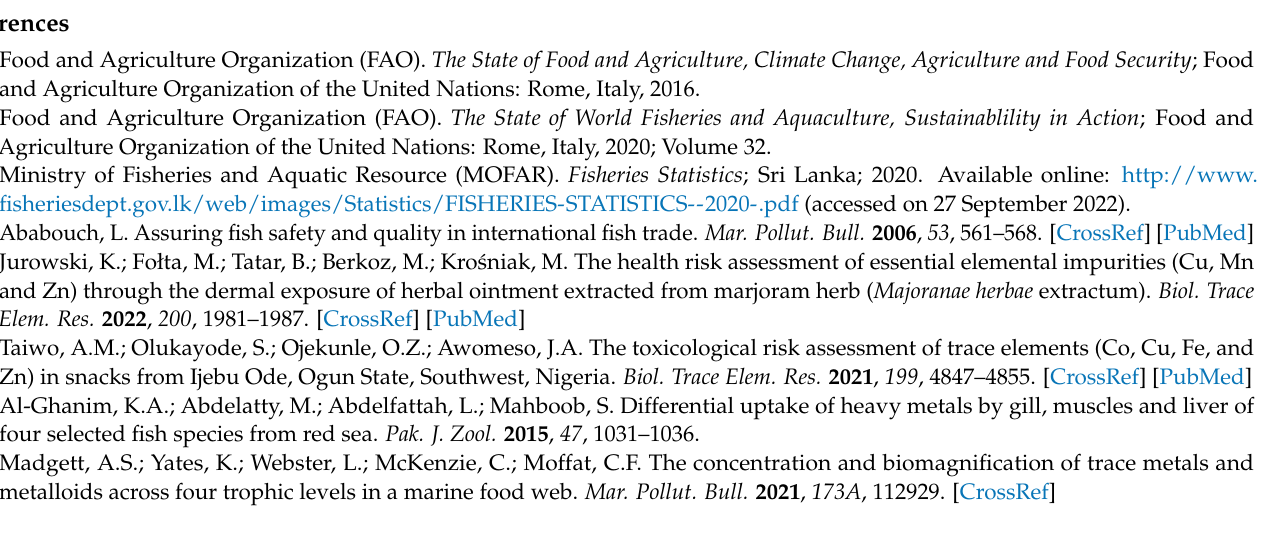
Sri Lanka; Figure S2: δ 15 N verses concentrations of EBTEs, NETs and Other elements between off-shore pelagic ( A ) and coastal and estuarine ( B ) aquatic organisms collected in Sri Lanka; Figure S3: Relationship between the concentration of mercury (mg/kg ww) and body weight of yellowfin tuna ( T. albacares ) collected in Sri Lanka; Table S1: Details of aquatic species and their information; Table S2: Concentration of toxic and other elements (mg/kg ww) in off-shore pelagic edible aquatic organisms collected in Sri Lanka; Table S3: Concentration of toxic and other elements (mg/kg ww) in coastal limits of toxic elements and the regulatory bodies